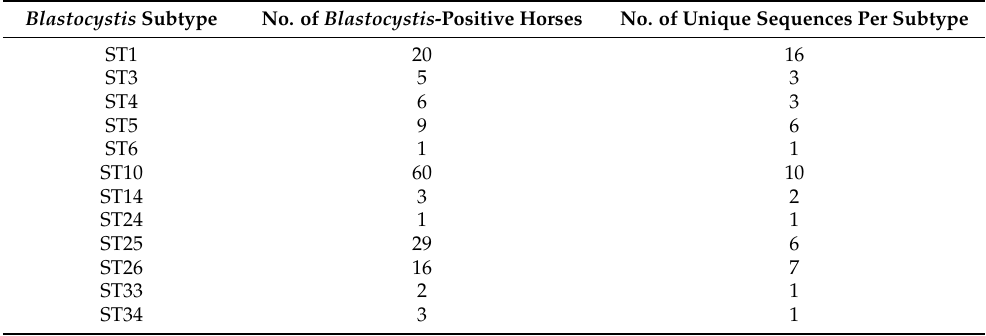
Table 6. Blastocystis subtypes identified in horses including number of positive horses in which each subtype was identified and number of unique sequences among each